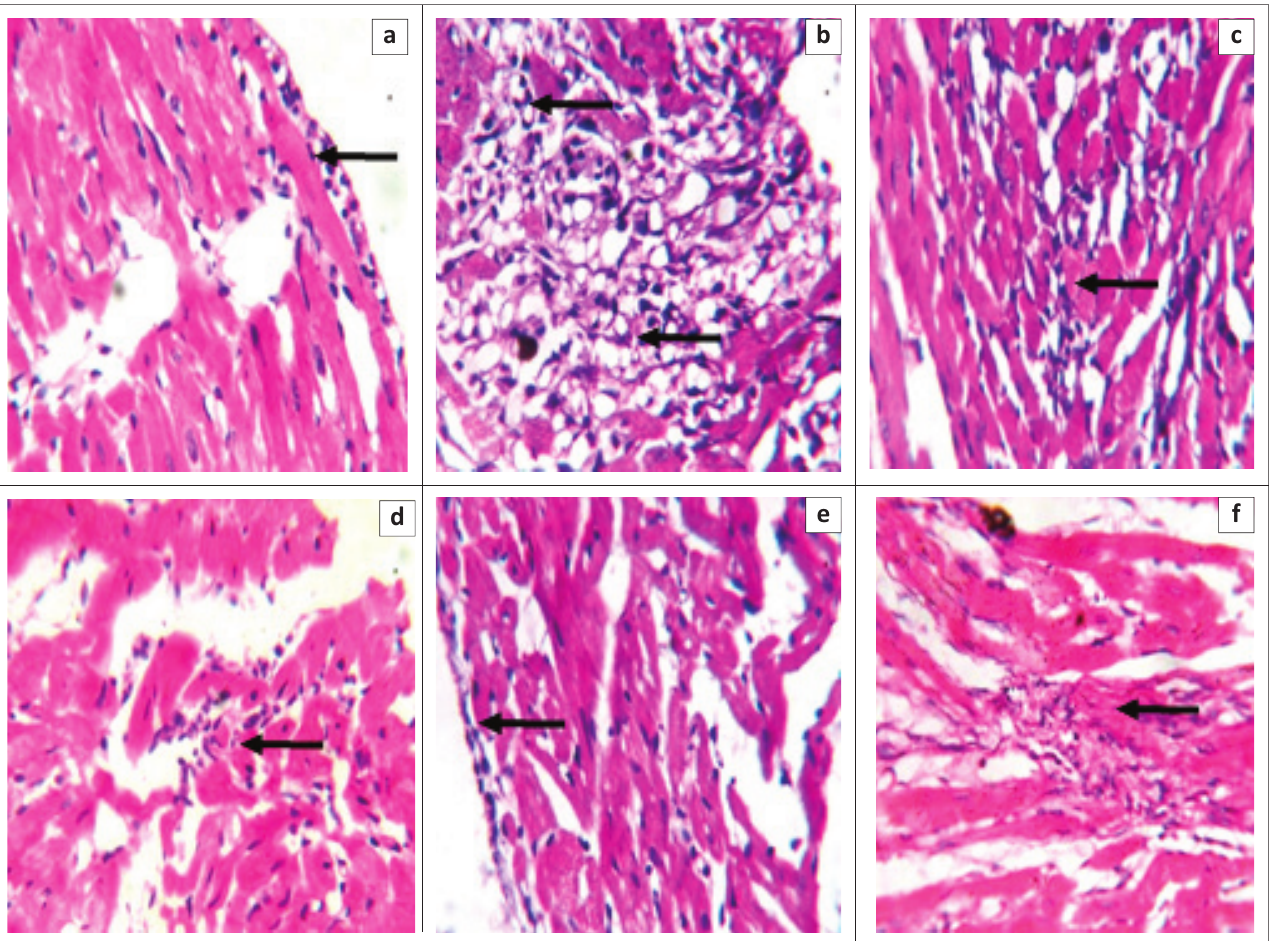
FIGURE 13: The histopathology of heart from isoproterenol-induced myocardial infarction using rats as a